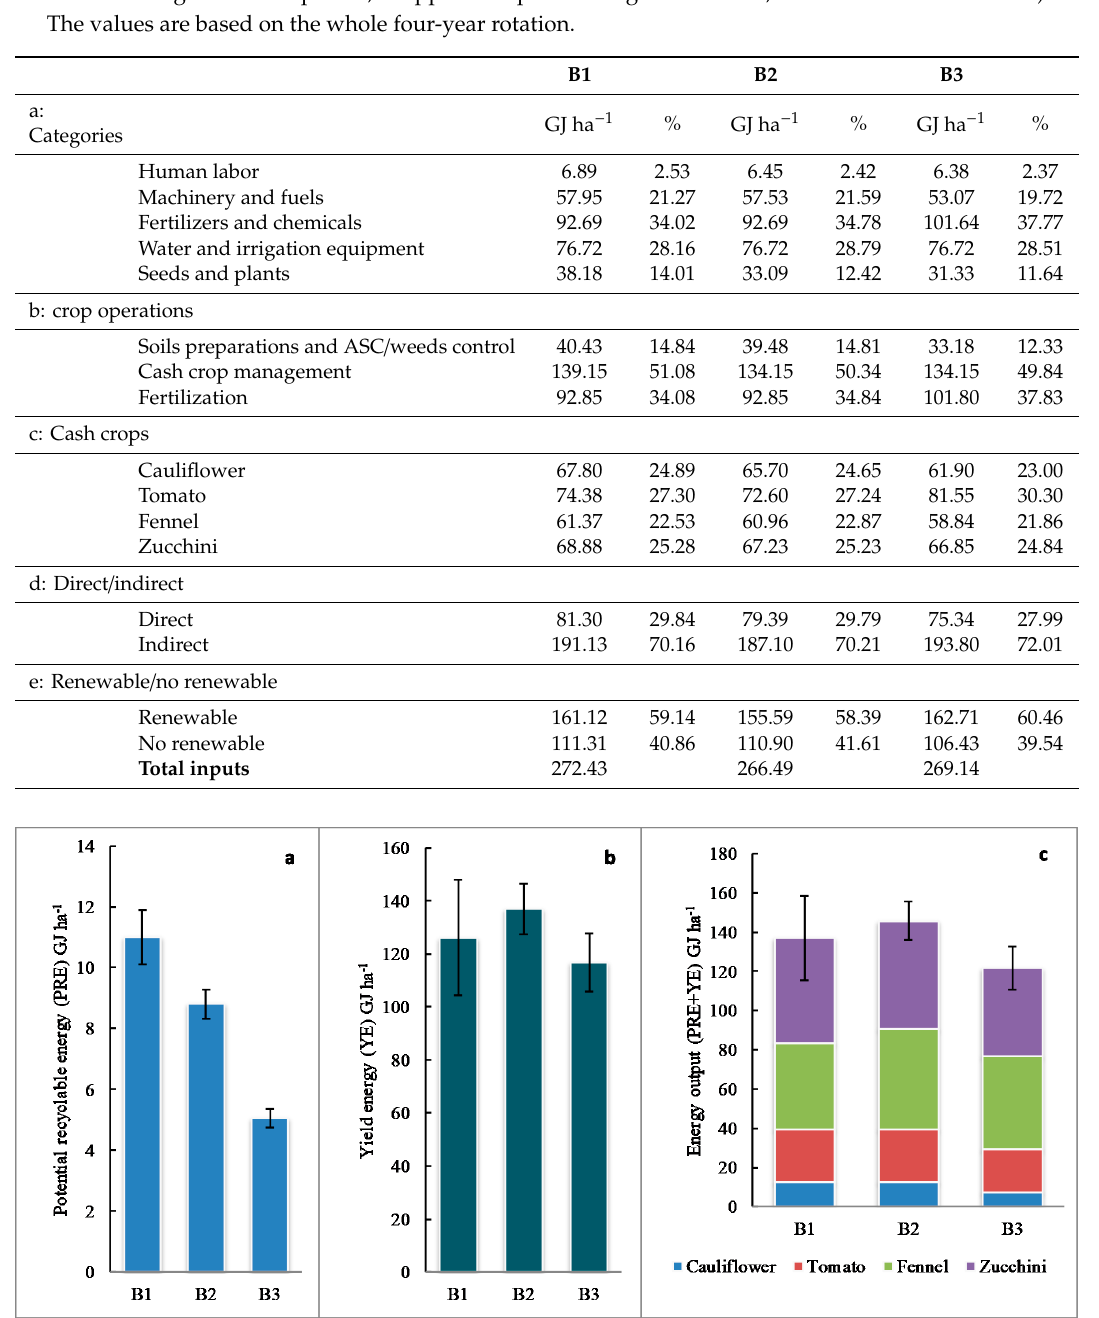
Figure 3. Energy output (GJ ha − 1 ): ( a ) potential recyclable energy (PRE) (ASC + weeds + plant biomasses); ( b ) yield energy (YE); ( c ) PRE + YE divided by crops (B1 = alfalfa as living mulch during both winter and summer periods, flattened with a no-till roller crimper; B2 = clover as living mulch during the winter period, chopped and plowed as green manure; B3 = control without